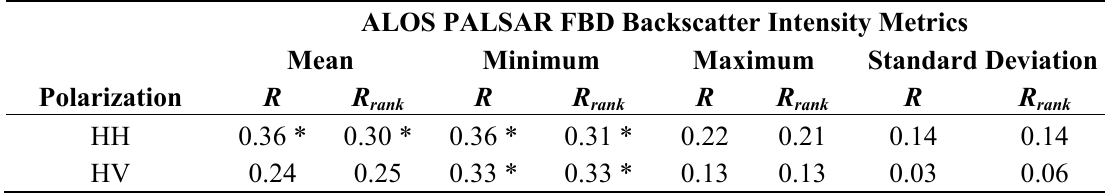
Table 2. Parametric Pearson’s coefficient of correlation ( R ) and non-parametric Spearman’s rank coefficient of correlation ( R ) between forest AGB and several metrics rank derived from the ALOS PALSAR FBD (HH and HV polarizations) backscatter intensity data (* significant at a significance level of 0.05).